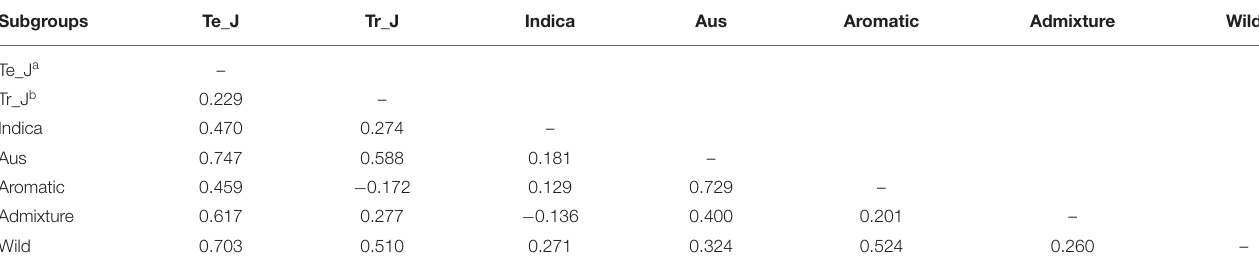
TABLE 2 | Pairwise estimates of genetic differentiation ( F ST values) of the GBSSI gene between different subgroups of 475 Korean rice collection accessions. Subgroups Te_J Tr_J Indica Aus Aromatic Admixture